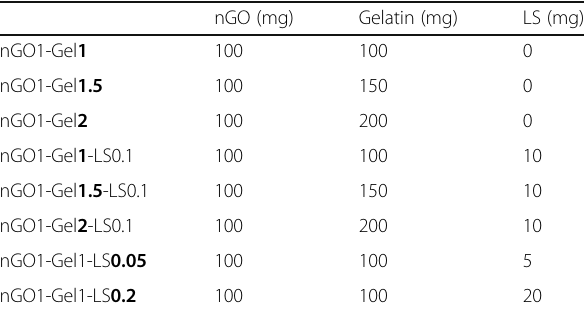
Table 1 Compositions by mass of the porous